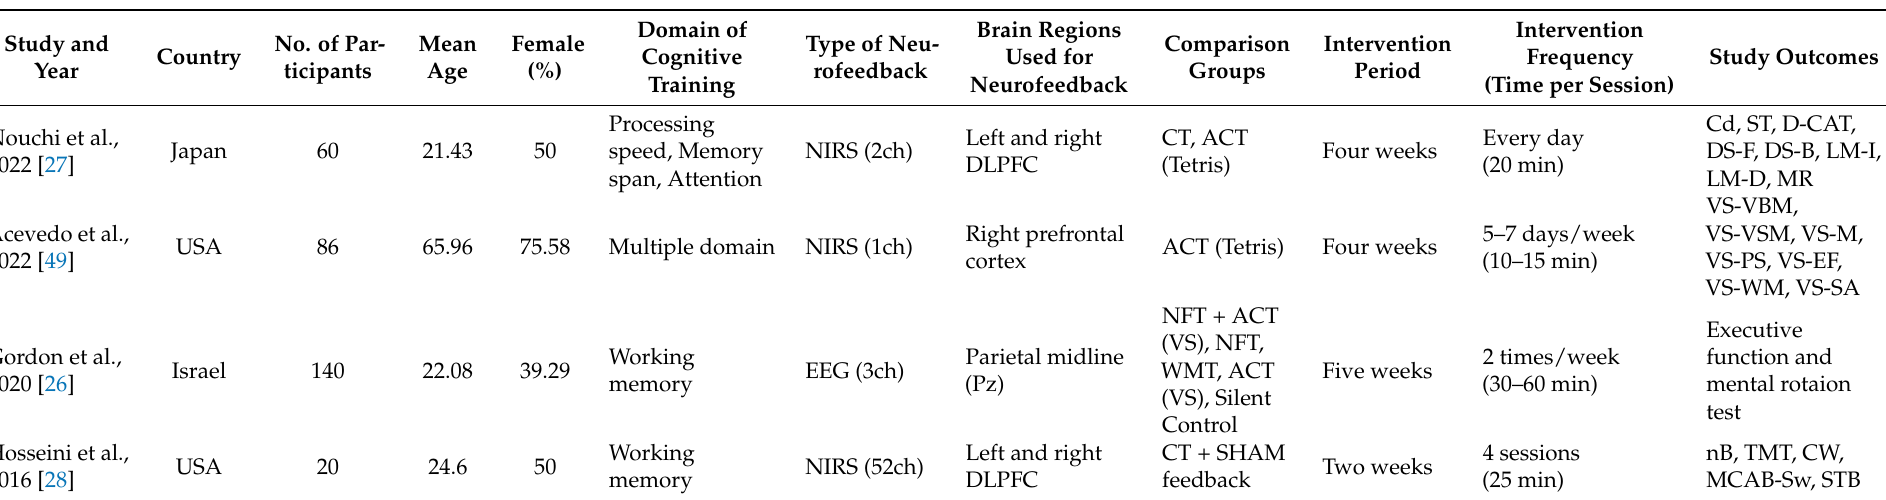
Table 1. Study characteristics of included